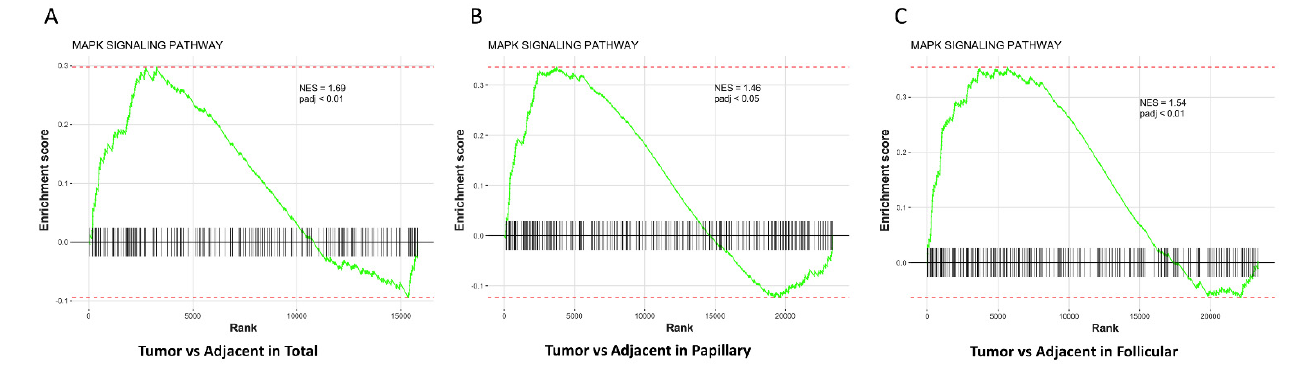
Figure 2. Gene set enrichment analysis (GSEA), enrichment plots based on normalized enrichment score (NES). ( A ). MAPK signaling pathway is significantly enriched in thyroid tumors (Total) vs. adjacent normal thyroid tissues (NES = 1.69, padj < 0.01). ( B ). MAPK signaling pathway is significantly enriched in papillary thyroid tumors vs. adjacent normal thyroid tissues (NES = 1.49, padj < 0.05). ( C ). MAPK signaling pathway is significantly enriched in follicular thyroid tumors vs. adjacent normal thyroid tissues (NES = 1.54, padj < 0.01).